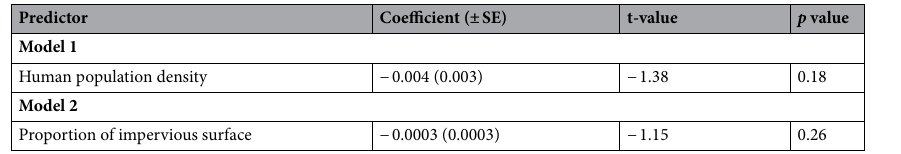
Table 2. Results (summary) of the two β-diversity models. Model 1 is the β diversity depending on the human population density, and Model 2 is the β-diversity depending on the proportion of impervious surface. %). Coefficients are given with their standard error.